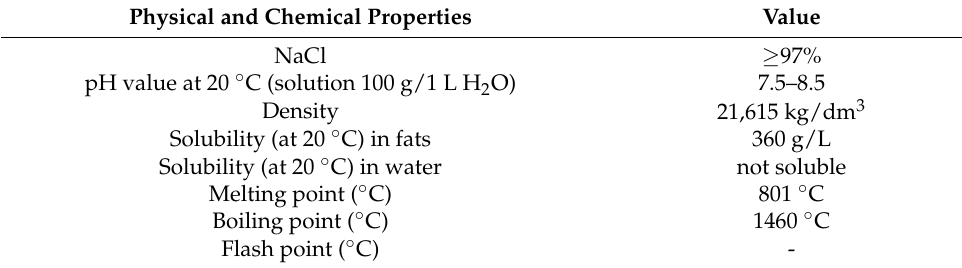
Figure 2. Freeze – thaw cycles (Photo: Authors). Figure 2. Freeze–thaw cycles (Photo: